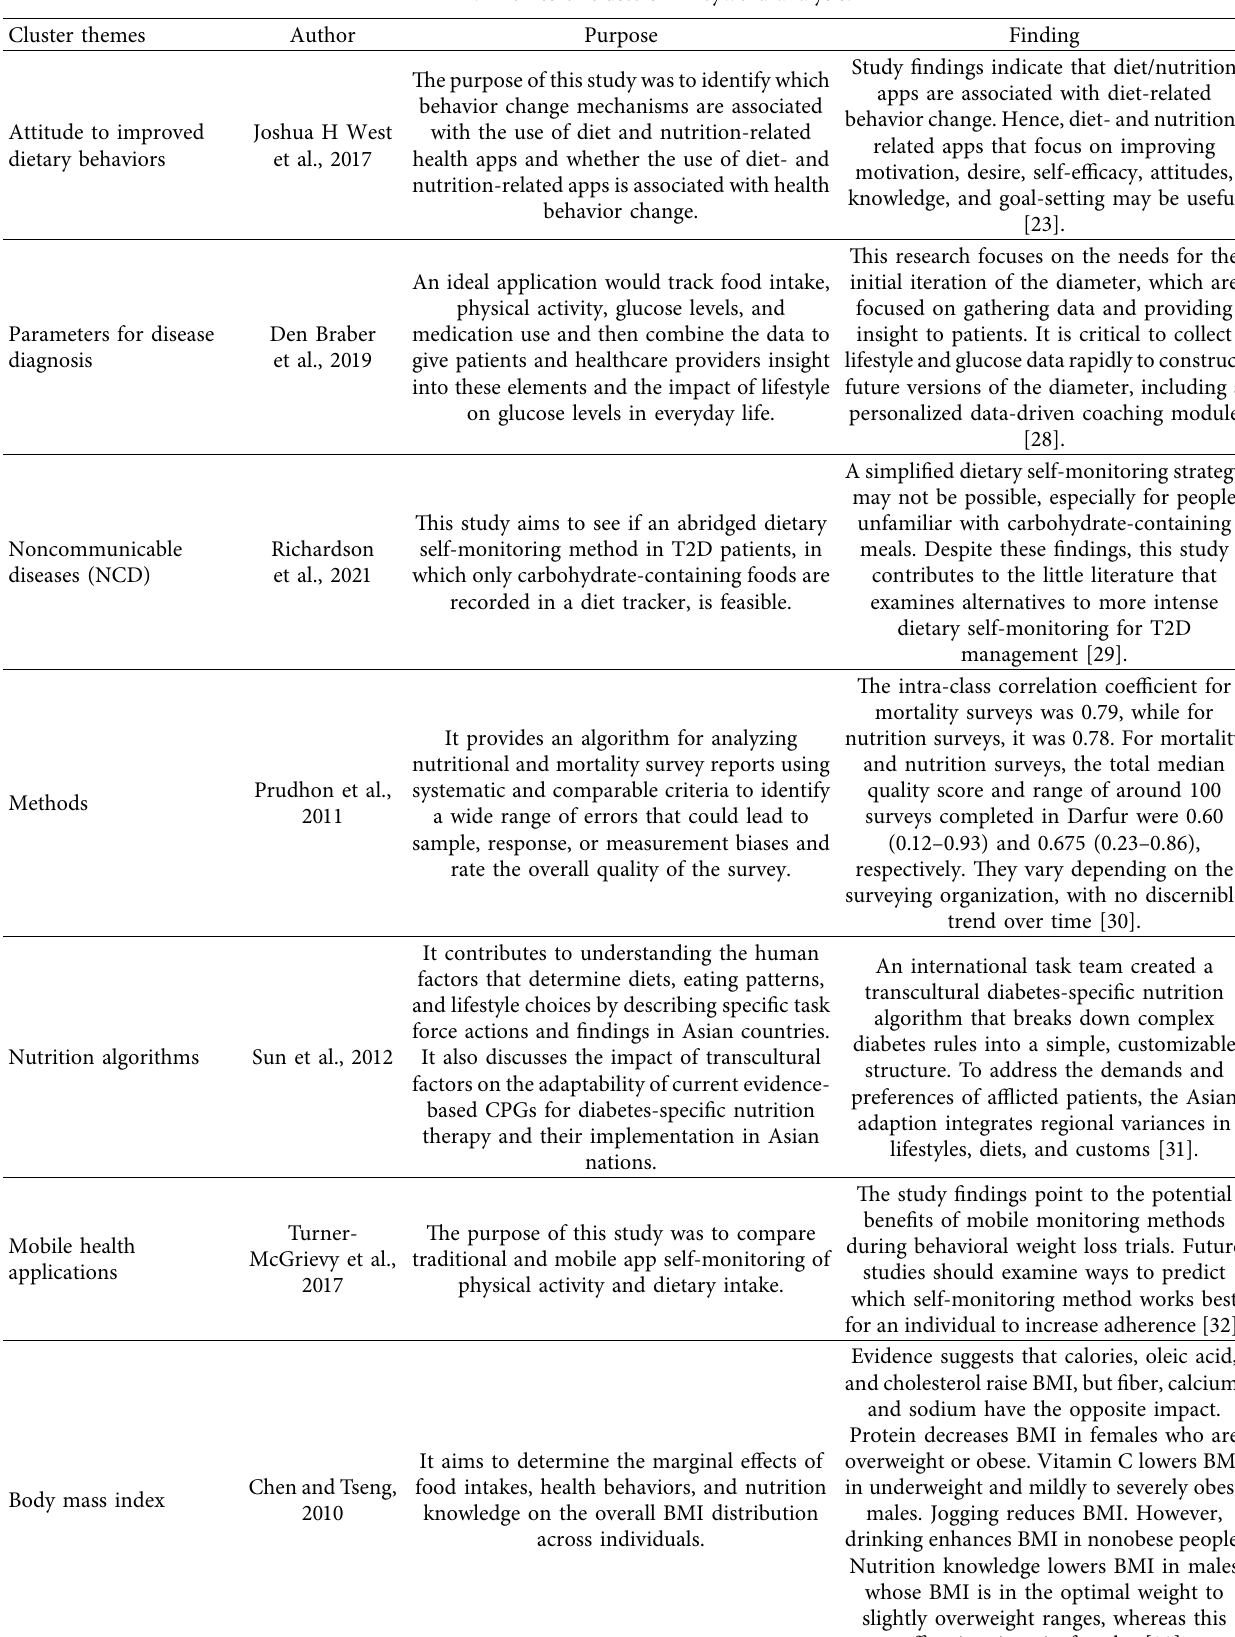
Table 2: Themes of clusters in keyword